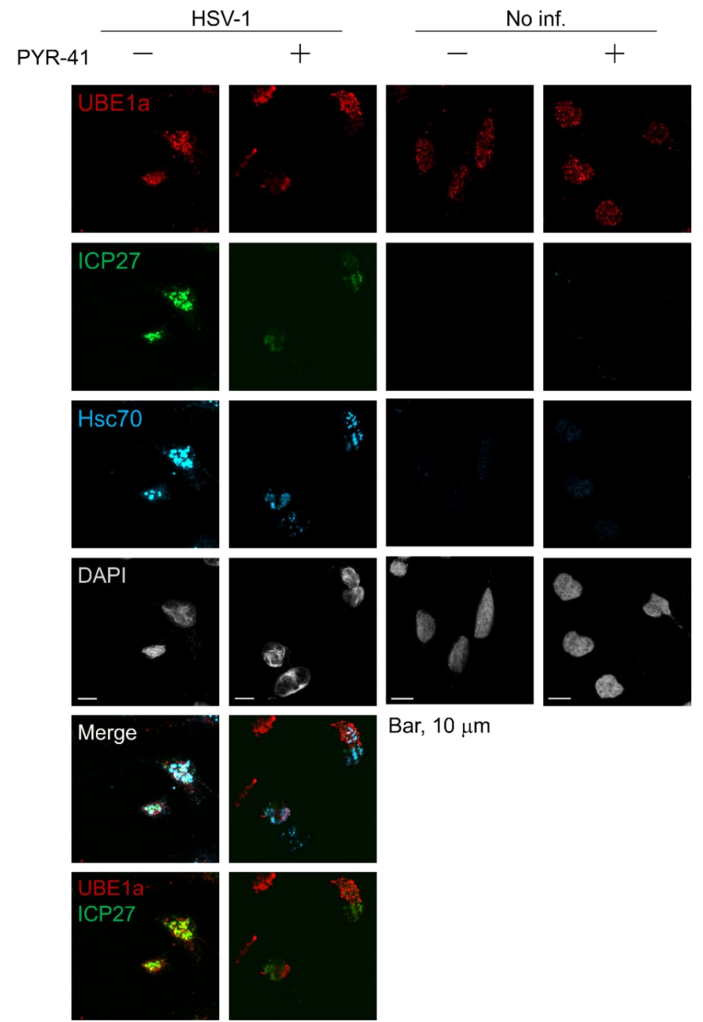
Figure 7. UBE1a inhibitor, PYR-41, decreased the co-localization of UBE1a and ICP27 at the Hsc70 foci / VICE domains in infected cells. HSV-1-infected HeLa cells were cultured for 18 h with or without 10 µ M PYR-41 and were extracted with ice-cold mCSK bu ff er. Cells were fixed in with 4% PFA and stained with anti-ICP27 (green), UBE1a (red), and Hsc70 (cyan)